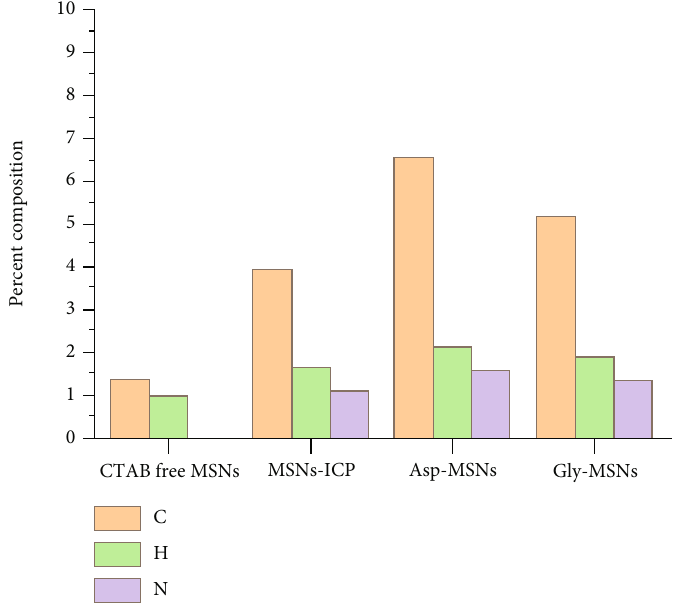
Figure 2: Elemental analysis for CTAB free MSNs, MSNs-ICP, Asp-MSNs, and